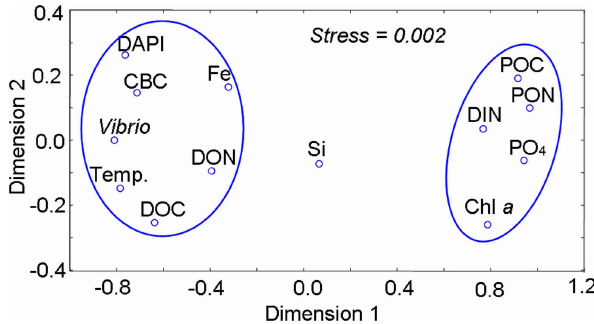
Fig. 4. Multi-dimensional scaling analysis of surface water sample data ( n = 26) including bacteriological parameters (DAPI, CBC and Vibrio ) and biogeochemical parameters (DIN: dissolved inorganic N, POC and PON: particulate organic C and N, respectively, for other abbreviations refer to Fig. 2). Variables having close affinity or strong correlation are